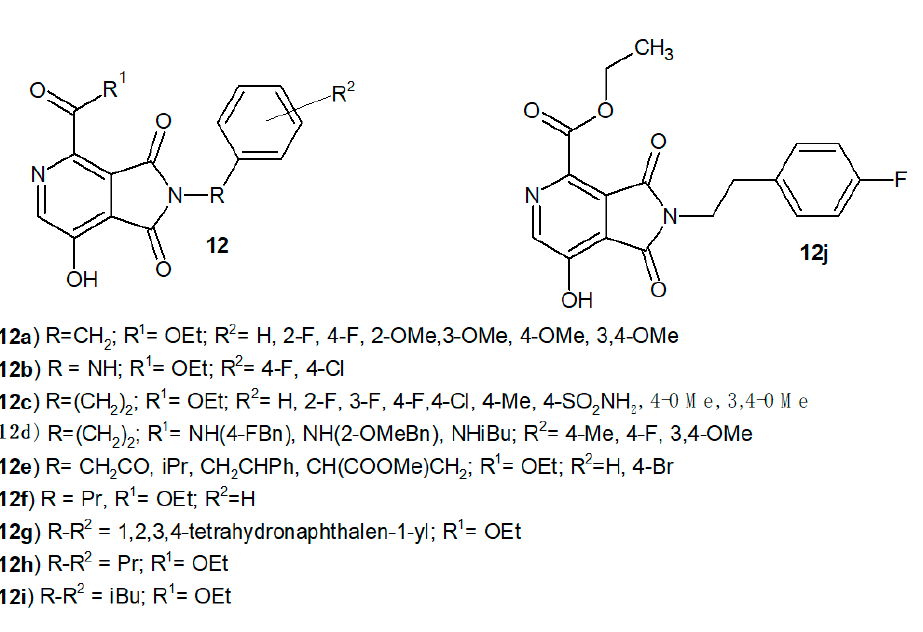
Figure 8. 7-Hydroxy-1,3-dioxo-2,3-dihydro-1 H -pyrrolo[3,4- c ]pyridine-4-carboxylate derivatives 12 Figure 8. 7 ‐ Hydroxy ‐ 1,3 ‐ dioxo ‐ 2,3 ‐ dihydro ‐ 1 H ‐ pyrrolo[3,4 ‐ c ]pyridine ‐ 4 ‐ carboxylate derivatives 12 and the most active compound 12j . and the most active compound 12j .